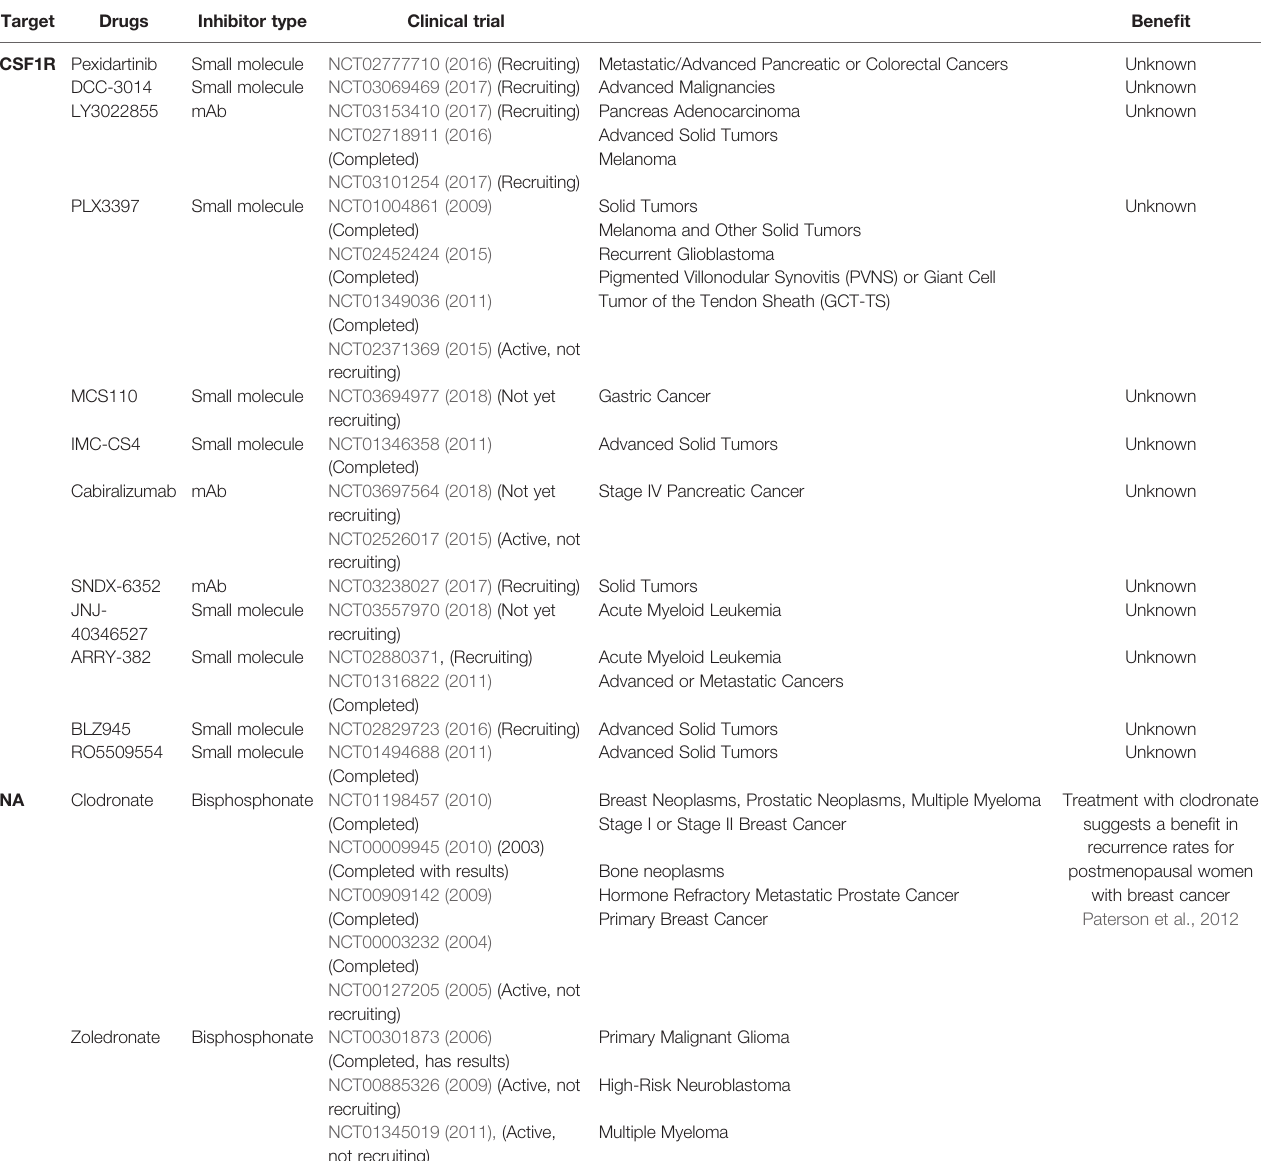
TABLE 3 | Clinical trials using drugs to deplete macrophages from the tumor ’ s microenvironment.